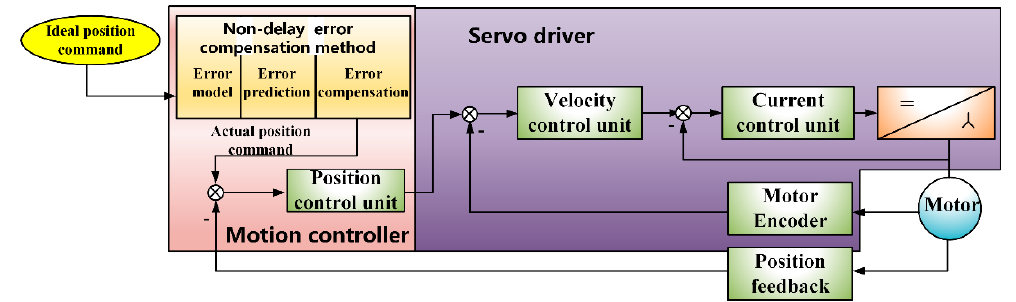
Figure 1. The structure of the non-delay error compensation controller.